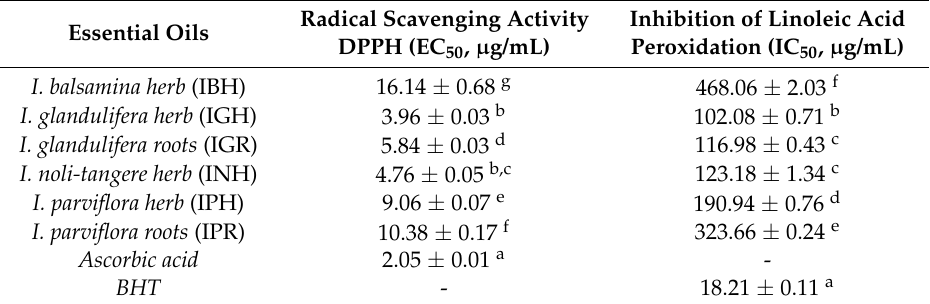
Table 2. Comparison of the antioxidant activity of Impatiens L. essential oils and standard antioxidants. Different superscripts in each column indicate significant differences in the means at p <